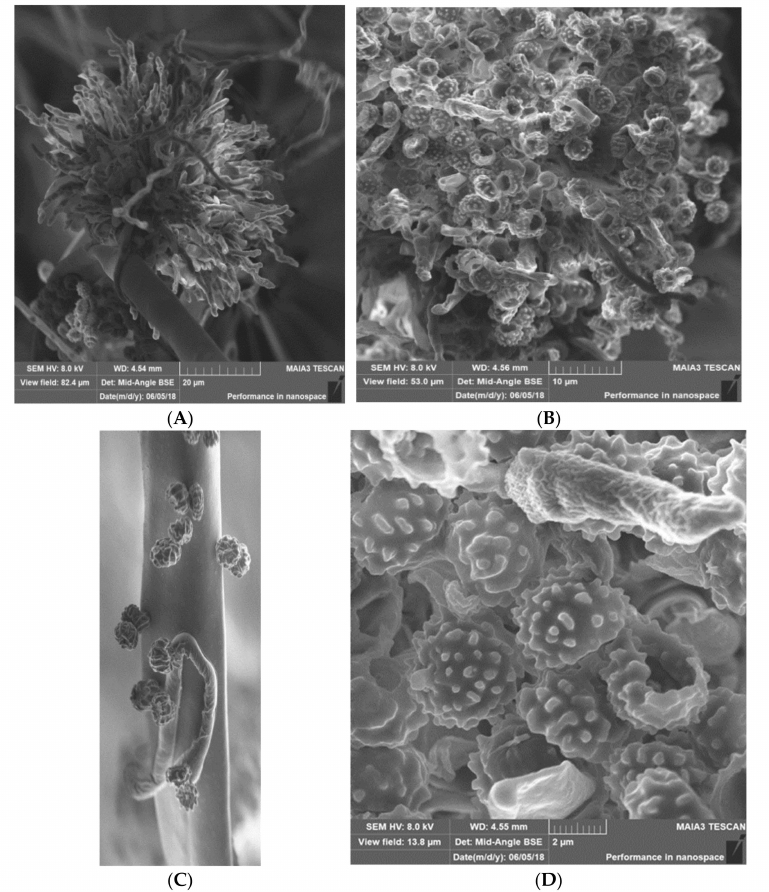
Figure 1. Morphology of Aspergilus niger . ( A )—general view, ( B )—the stage of development of the conidiophoid, ( C )—the adhesion of spores to the porous structure of the vegetative mycelium hyphae, ( D